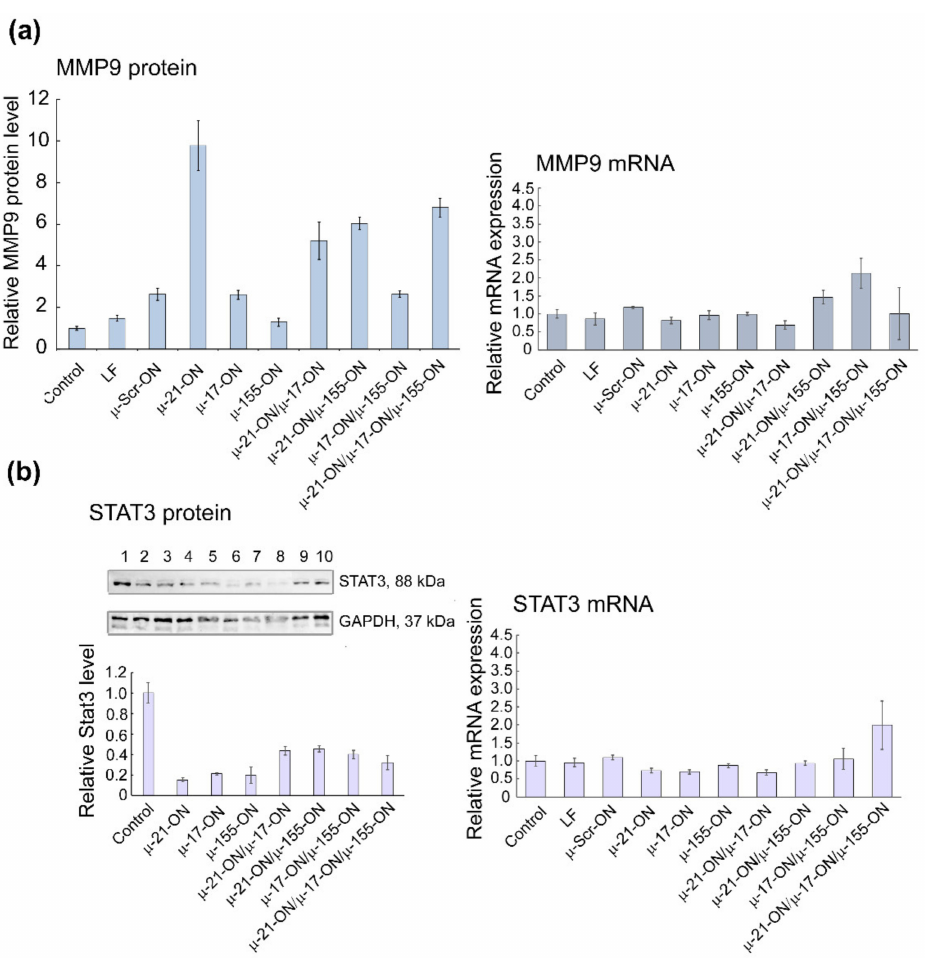
Figure 9. Analysis of mRNA and protein levels of genes, regulated by miR-21, miR-17 and miR- 155 in murine melanoma B16 cells after treatment with µ -oligonucleotides. ( a ) Relative level of MMP9 protein measured by flow cytometry analysis and relative expression of MMP9 mRNA measured by qPCR 72 h after mono- and combinative treatment with µ -oligonucleotides. ( b ) Relative level of STAT3 protein measured by Western blot analysis and relative expression of STAT3 mRNA measured by qPCR 72 h after mono- and combinative treatment with µ -oligonucleotides. The numbers above the Western blot image correspond to the following experimental groups: 1—Control (intact B16 cells); 2—B16 cells incubated with Lipofectamine2000 TM ; 3, 4, 5, and 6—cells incubated with singular oligonucleotides µ -Scr-ON, µ -21-ON, µ -17-ON, and µ -155-ON, respectively, in the 150 nM concentration; 7—cells incubated with µ -21-ON/ µ -17-ON pair (75 nM of each ON); 8—cells incubated with triple combination µ -21-ON/ µ -17-ON/ µ -155-ON (50 nM of each ON); 9 and 10—cells treated with pairs µ -21-ON/ µ -155-ON and µ -155-ON/ µ -17-ON, respectively (75 nM of each ON). The level of STAT3 protein was normalized to the level of GAPDH